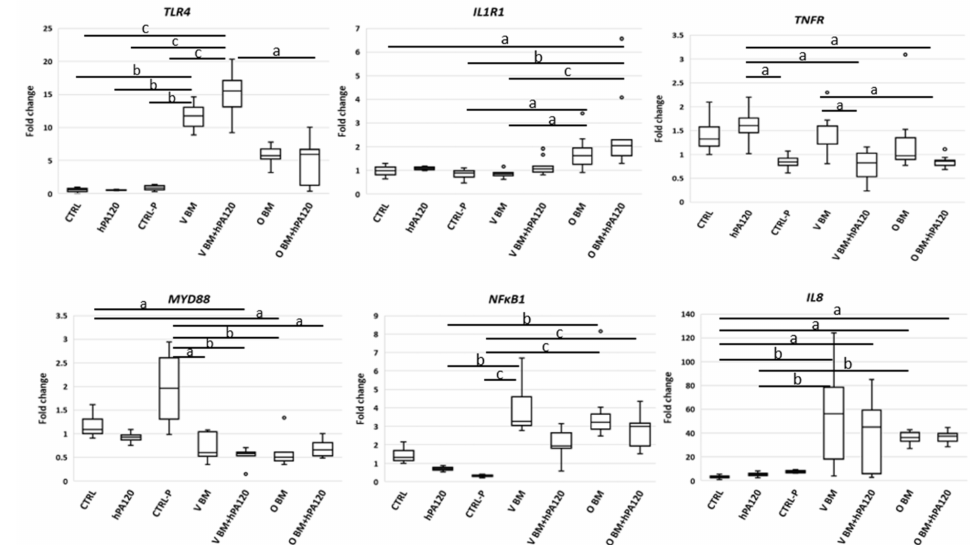
Figure 3. Gene expression in NCM460D cells treated with fecal bacteria derived from vegan (V) or omnivorous (O) volunteers. Fecal bacteria were grown in Wilkins–Chalgren medium supplemented with 0.5% of mucin and 1 mM of phytic acid for 42 h at 37 ◦ C in an anaerobic atmosphere. The treatment was performed with bacteria alone (BM) or with bacteria and the hydrolysate of phytic acid (BM + hPA120), for 2 h at 37 ◦ C. The controls were: non-treated colonocytes (CTRL), colonocytes treated with hPA120 and colonocytes treated with non-inoculated microbiological medium treated as bacterial cultures (CTRL-P). Whiskers—non-outliers, box—25–75% non-outliers; horizontal line in the box—median; circles—outliers. Kruskal–Wallis was applied to calculate significant differences between the treatments, which are marked with: a—values different at p < 0.05; b—values different at p < 0.01; c—values different at p <